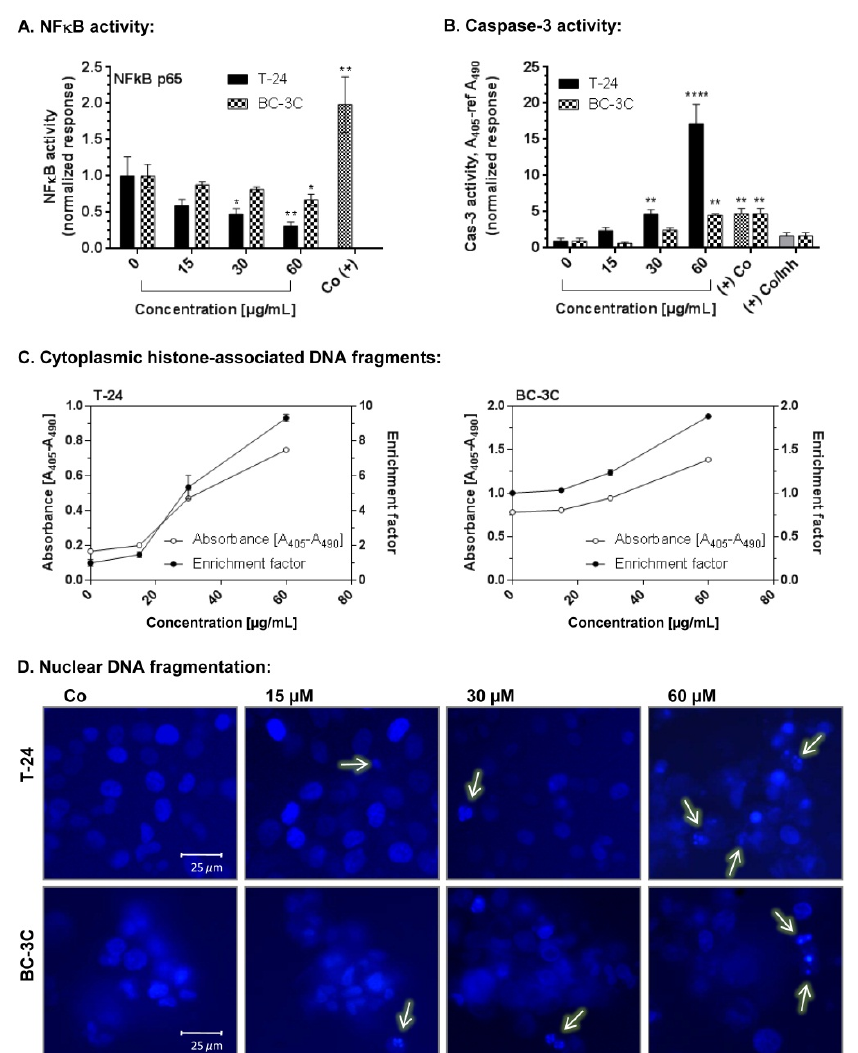
Figure 2. NFkB inhibition and induction of apoptosis in T-24 and BC-3C cell lines after treatment with EtOAc-AP extract of G. urbanum . The asterisks above the columns denote the p -value from the statis- tical analysis with one-way ANOVA obtained by comparison with the untreated control—* p < 0.05, ** p < 0.01, **** p < 0.0001; enrichment factor—normalization of the values against the untreated control assumed to be 1. Legend: ( A) —activity of NF- κ B p65 in T-24 and Bc-3C cells after exposure to three different concentrations of EtOAc-AP; ( B )—activation of caspase 3 in T-24 and Bc-3C cells after exposure to three different concentrations of EtOAc-AP; ( C )—accumulation of cytoplasmatic histone-associated DNA fragments in T-24 and Bc-3C cells after exposure to three different concentrations of EtOAc-AP; the two lines on each graph represent the absorbance (left y -axis) and the fraction of the untreated control (right y -axis); ( D )—nuclear DNA fragmentation in T-24 and BC-3C cells after exposure to three different concentrations of EtOAc-AP; field magnifi- cation – 400x. The results obtained regarding the total glutathione (GSH) levels (Figure 3) showed their small but significant decrease in BC-3C cells incubated with 60 µg/mL of the tested extract and in T-24 cells after treatment with 30 or 60 µg/mL extract. Lower EtOAc-AP concentrations ( ≤ 15 µg/mL) led to an increase or had no impact on the synthesis of GSH.